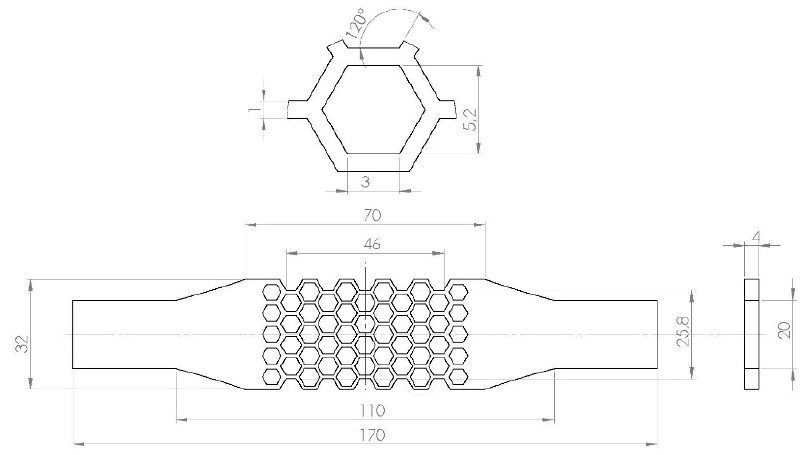
Figure 1. Geometry of tensile specimen with honeycomb structure.